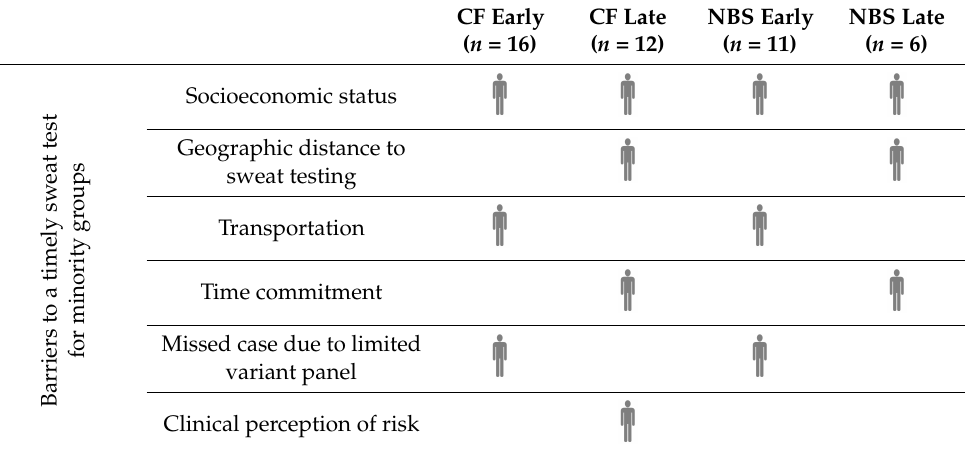
Table 5. Key themes identified listed by analysis groups when participants were asked, “What are the barriers to a timely sweat test for minority groups?”; themes identified by at least 30% of the group are represented by one figure; themes identified by at least 60% are represented by two